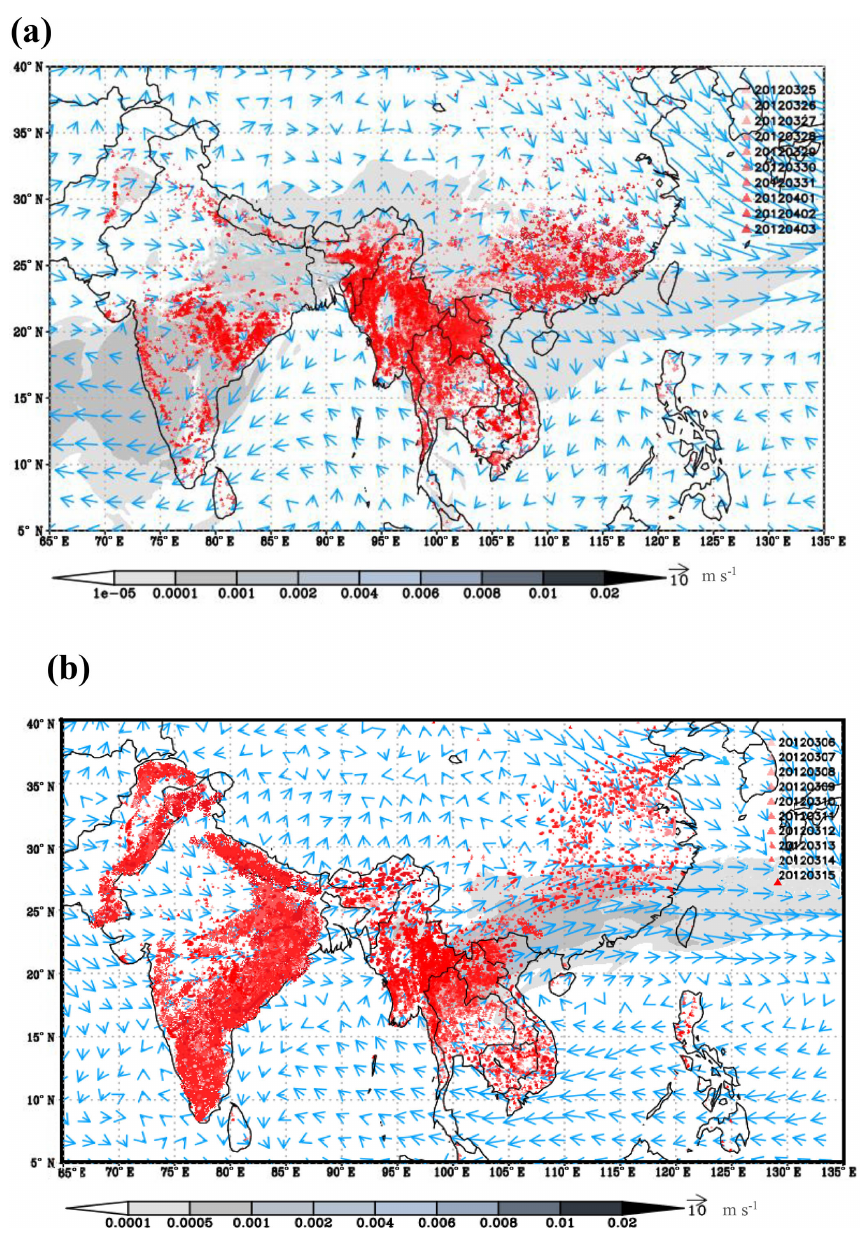
Figure 7. MODIS fires on surface of ground and WRF-Chem modeled results of BB plumes at the altitude of 700hPa on (a) 3 April and (b) 15 March. The blue arrows and lines denote the wind directions and wind speeds, respectively. The grey shadows represent tracer